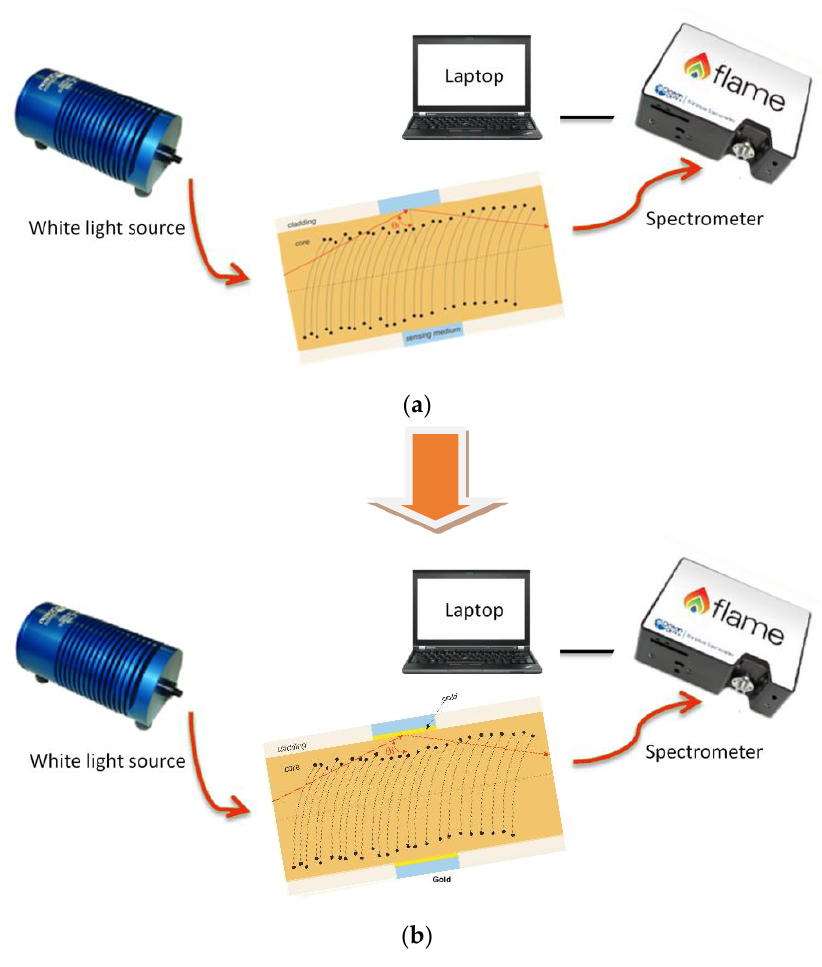
Figure 2. Outline of the LDF sensor systems: ( a ) Intensity-based LDF sensor; ( b ) SPR-LDF sensor.